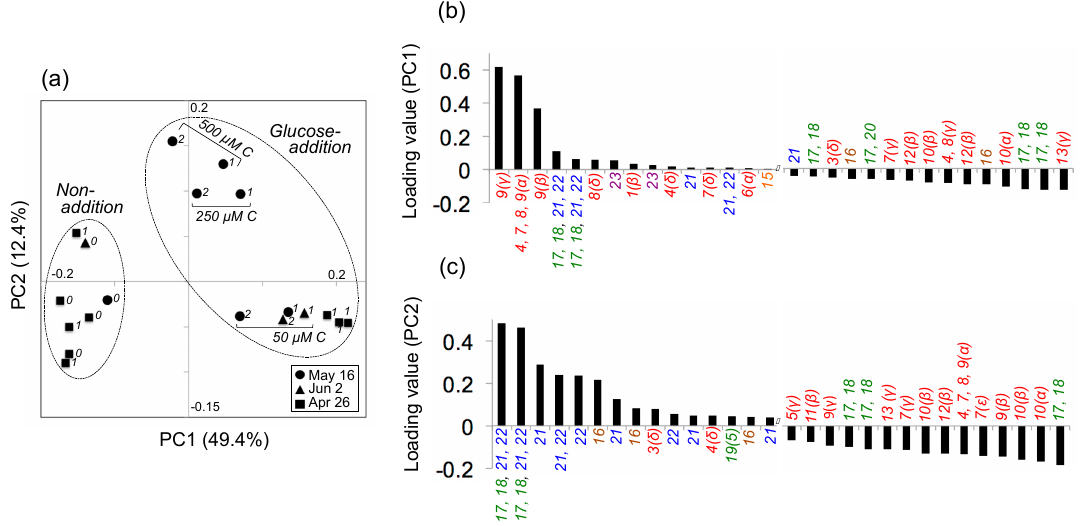
Figure 3. ( a ) Results of principal component analysis of the variability in metabolite composition of samples incubated for different periods and with different 13 C 6 –glucose concentrations. Metabolites were transformed from 13 C 6 –glucose by a natural aquatic bacterial community, using coastal seawater samples collected on 16 May 2016, 2 June 2016, and 26 April 2017. Numbers in italics beside the symbols indicate the incubation period (days). Non-addition: treatment in which the original seawater was incubated without added 13 C 6 –glucose; glucose-addition: treatment in which the seawater sample was incubated after adding 13 C 6 –glucose (50, 250, or 500 µ M C). Loading values for principal components ( b ) 1 (PC1) and ( c ) 2 (PC2), showing the top and bottom 15 metabolite signals. Numbers indicate the corresponding metabolites listed in Table 1 (amino acids: red; dipeptides: orange; carboxylic acids: brown; nucleosides and nucleobases: green; carbohydrates: blue; amino alcohols: purple). Greek letters or numbers in parentheses for amino acids and nucleobases, respectively, denote the atom designation. See also Figure S2 for the compounds and chemical classes shown in ( b , c ). For detailed analytical settings, see Table S1.